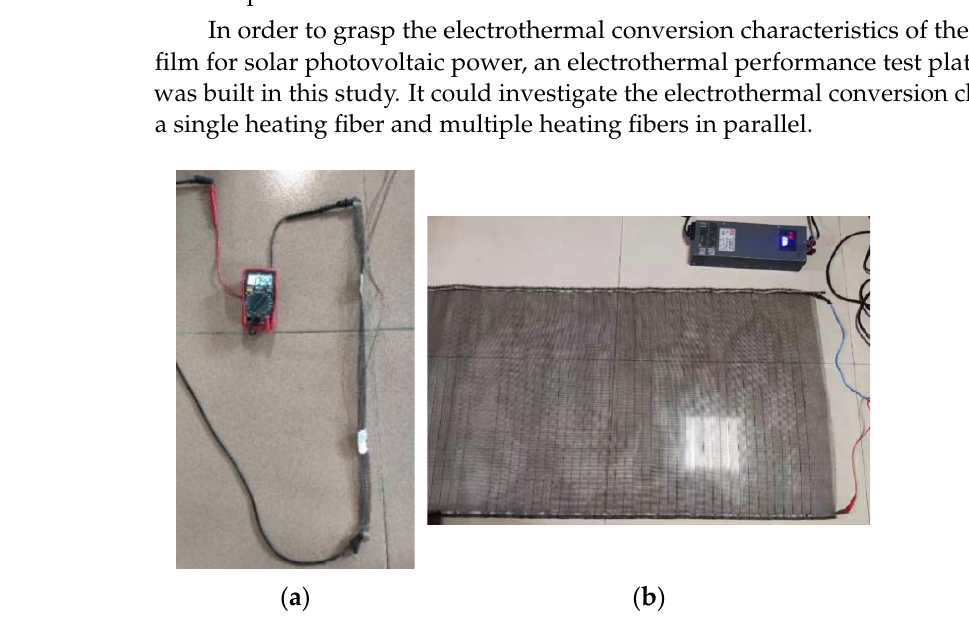
Figure 6. Real view of experimental system for determining the electrothermal conversion characteristics of the electrothermal film. ( a ) Single heating fiber. ( b ) Multiple heating fibers.